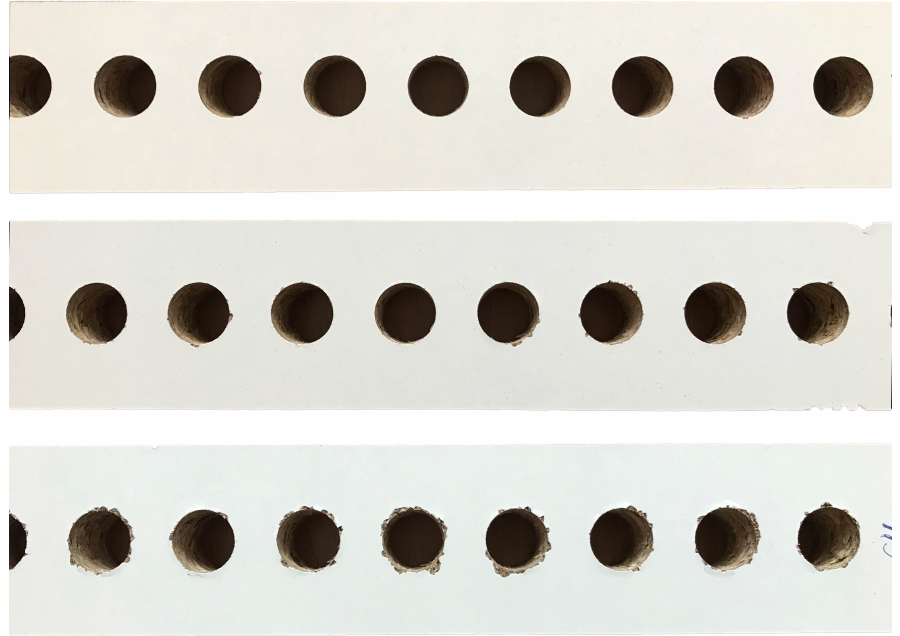
Figure 1. Images showing photographed samples after division into smaller elements, representing holes made by drills with different drill wear classifications: green ( top ), yellow ( middle ), and red ( bottom ).